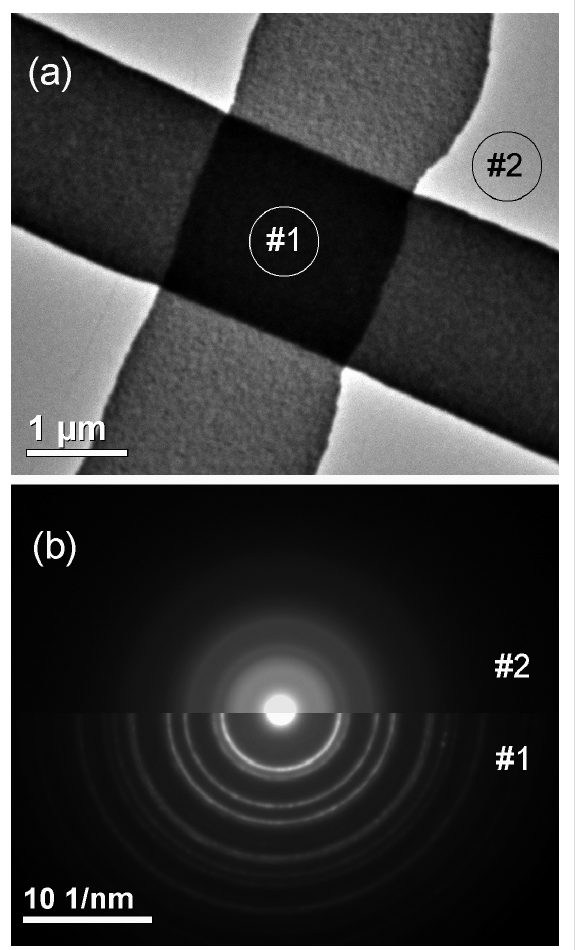
Figure 4: (a) Low-magnification TEM image of the junction region from a forming-free device in the ON state. (b) SAED patterns obtained in the two regions indicated in